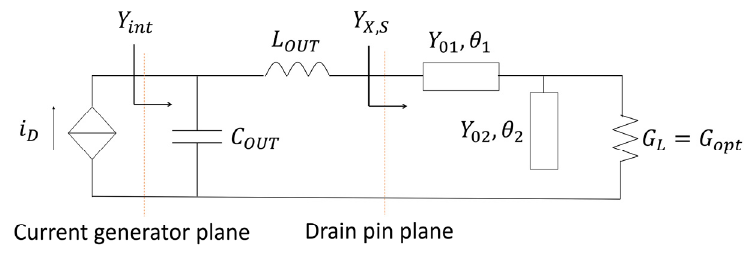
Figure 1. Proposed